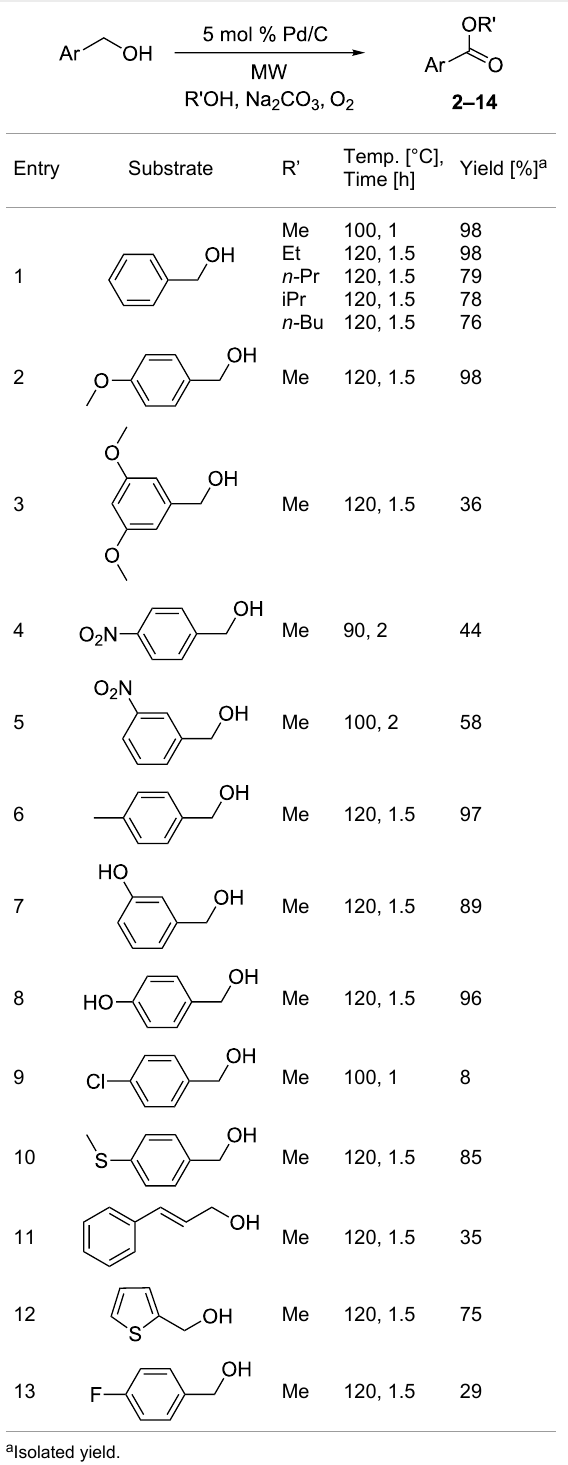
Table 3: Oxidative esterification of various